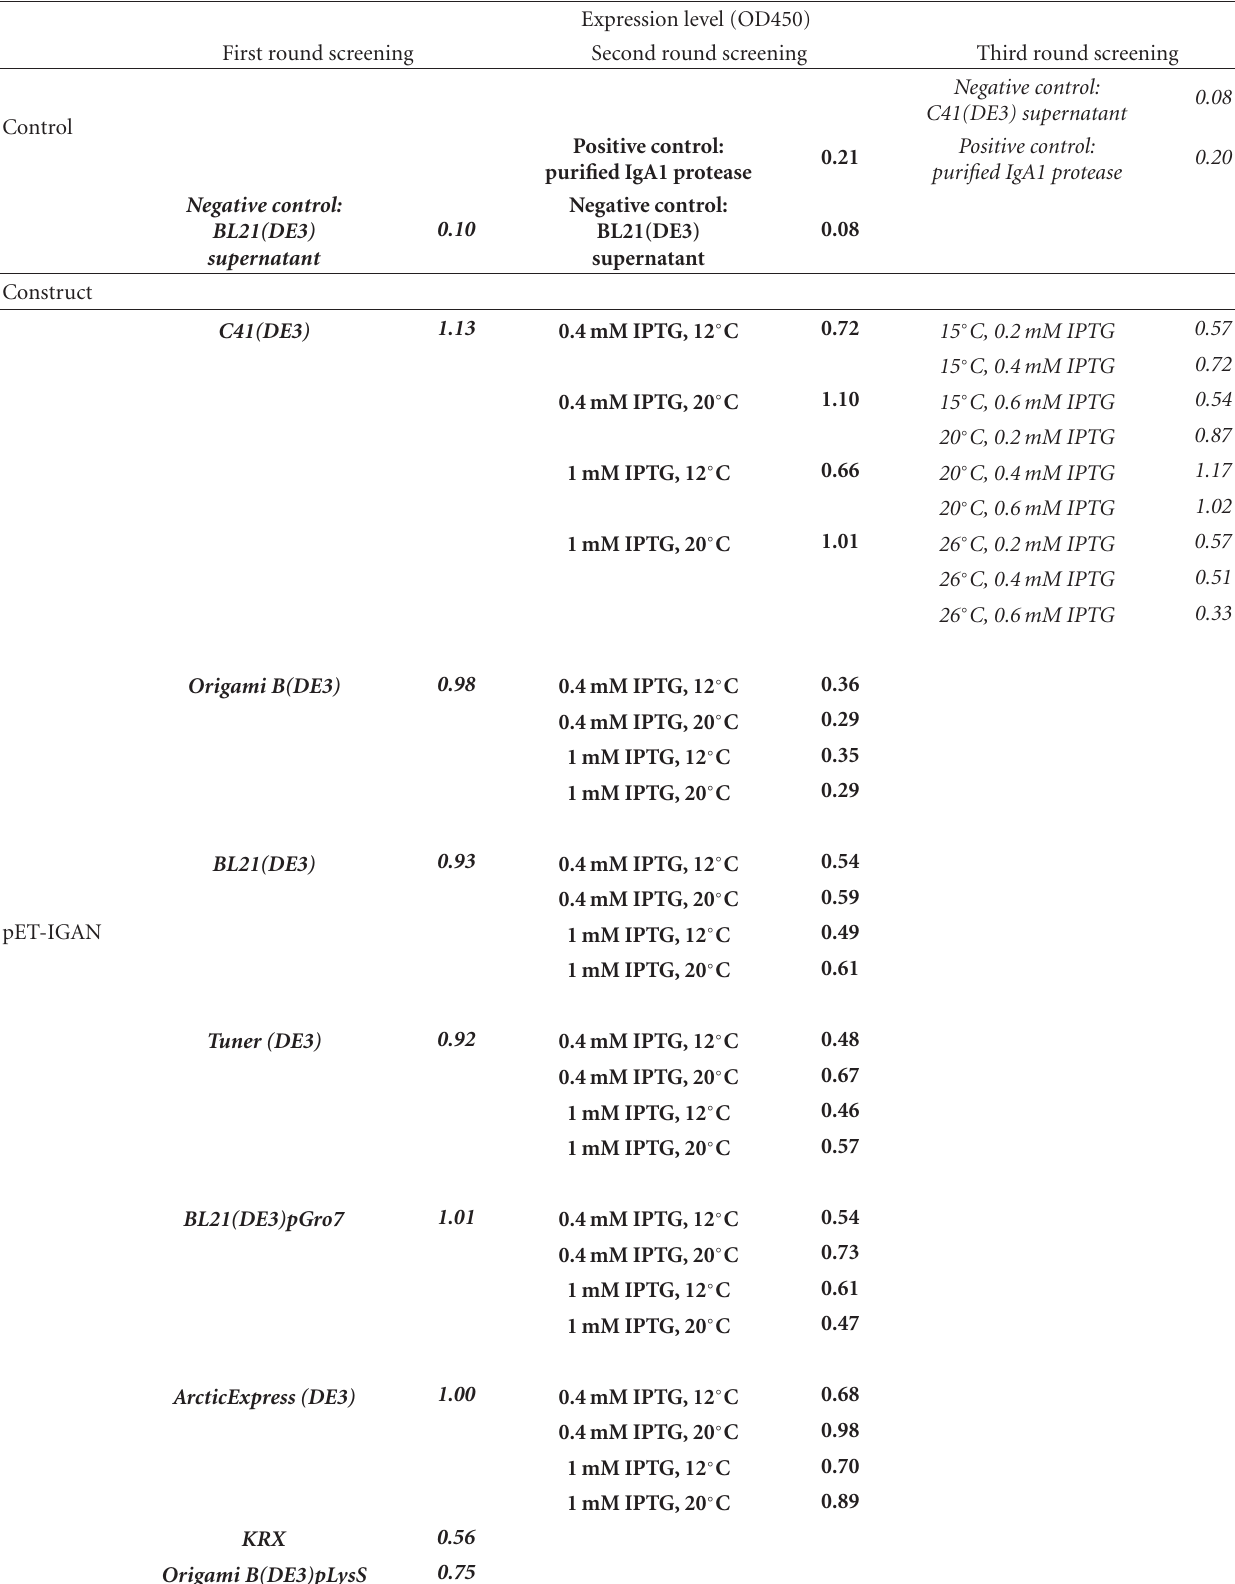
Table 2: Screening the expression of soluble IgA1 proteases by